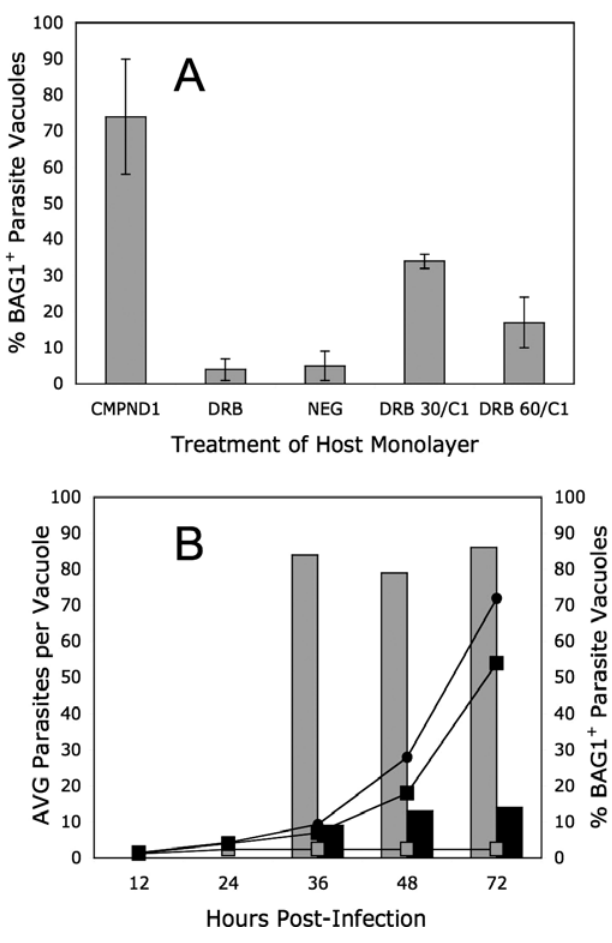
Figure 2. Compound 1–Induced Slowing of Parasite Growth and BAG1 Expression Is Mediated by New Host Cell Gene Transcription (A) HFF cells were treated or co-treated for 3 h with 3 l M Compound 1 and 30 or 60 l M RNA polymerase II inhibitor DRB. Following removal of the compounds, VEG parasites were inoculated and BAG1 expression was evaluated 72 h postinfection. Antagonism of Compound 1 induction of parasite BAG1 with DRB shows a dose effect when comparing co- treatment with 30 or 60 l M DRB and 3 l M Compound 1 (DRB 30/C1 and DRB 60/C1, respectively). DRB alone had no effect on parasite growth or BAG1 expression, while induction by 3 l M Compound 1 (CMPND1) is included here for reference. (B) In untreated cultures, VEG parasites reach greater than 70 per vacuole by 72 h postinfection (black circle), but vacuoles with an average of only four parasites were observed in Compound 1–treated cells (grey box). Co-treatment with 60 l M DRB restored parasite replication to approximately 60 parasites per vacuole (black box) by 72 h postinfection, while reducing the level of BAG1 þ to 12% (dark bars) from greater than 70% in cultures treated with Compound 1 alone (light